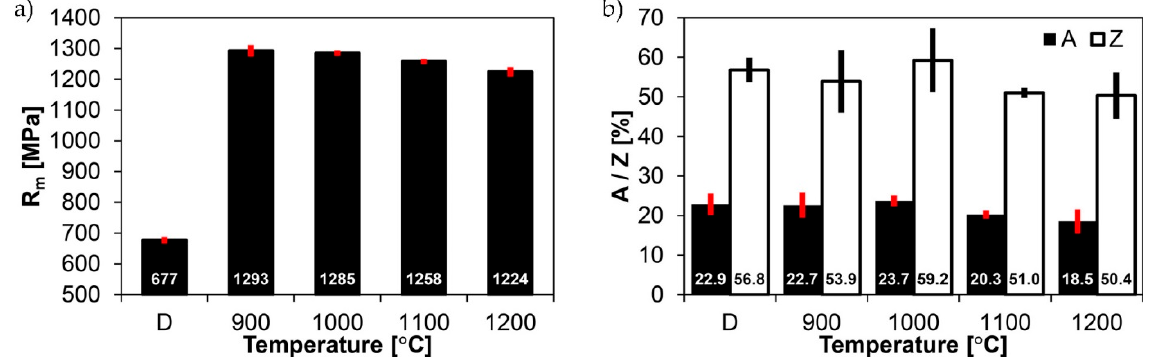
Figure 20. Strength tests results of welded joints of Hardox 450 steel in the delivery state and after quenching from austenitisation temperature in the range 900–1200 ◦ C: ( a ) tensile strength, ( b ) percentage elongation after fracture and reduction of area. D—delivery state (directly after